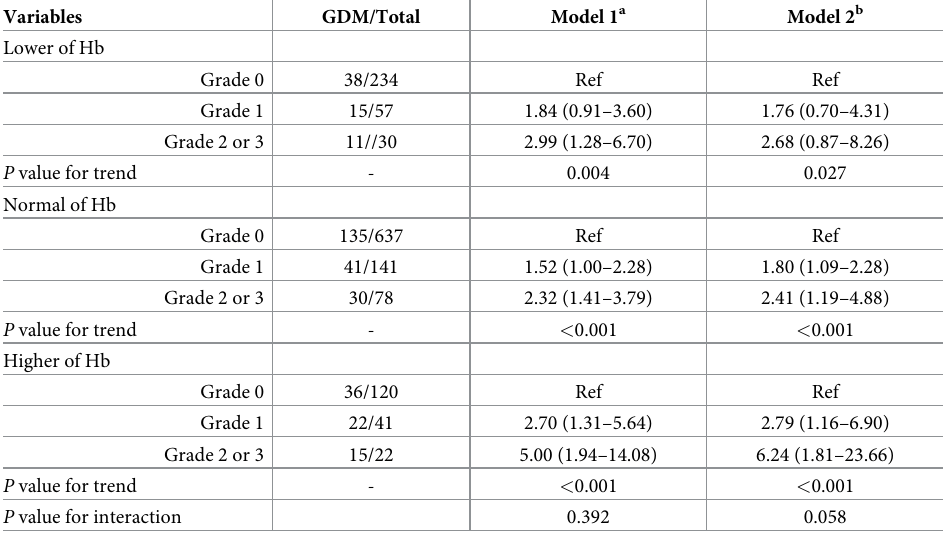
Table 3. OR and 95% CI between steatosis and GDM stratified by first trimester Hb